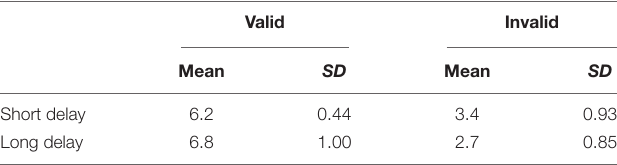
TABLE 1 | Means and standard deviations of the number of valid and invalid trials for each condition. Valid Invalid Mean SD Mean SD